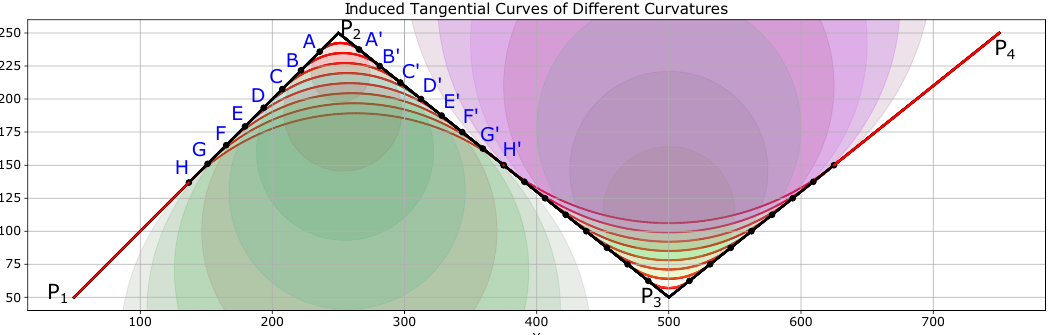
Figure 13. ITC path generation with different curvatures.